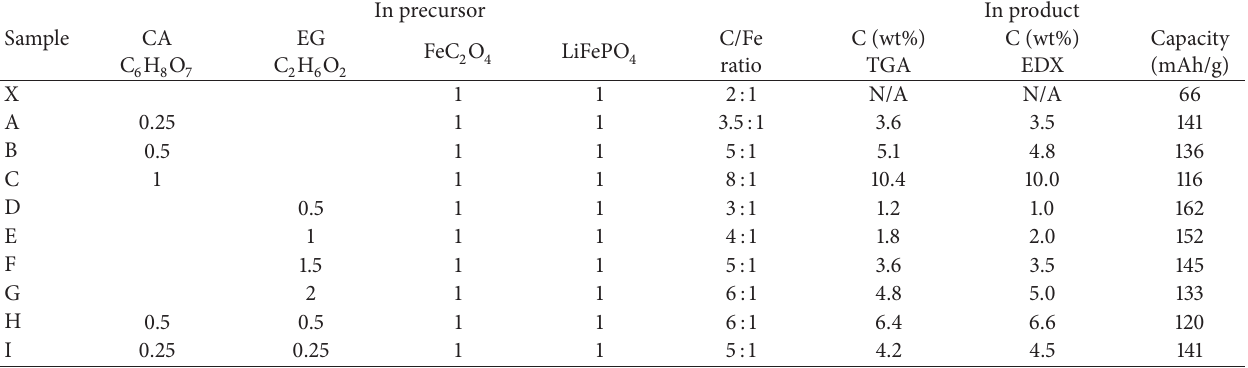
Table 1: The different molar composition in the precursors results in the variation of carbon content and the reversible discharge/charge capacity of the final products.